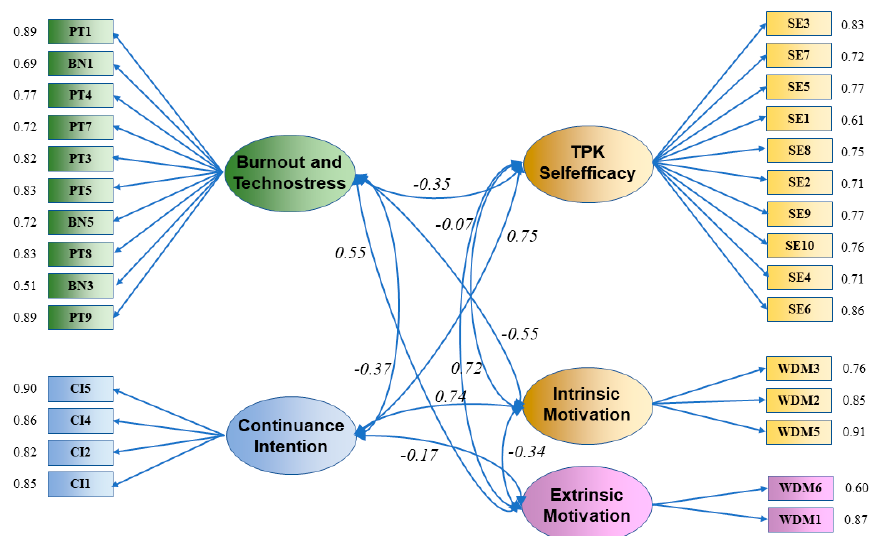
Figure 3. Results of CFA with five subscales. Coefficients mentioned in line with each item are standardized factor loadings. Correlation coefficients between model dimensions are in italics. All coefficients are statistically significant .